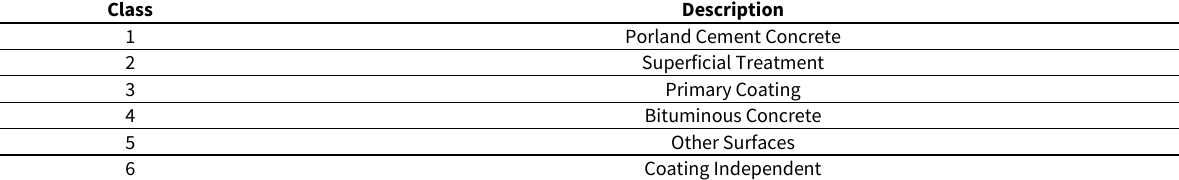
Table 2. Pavement Type